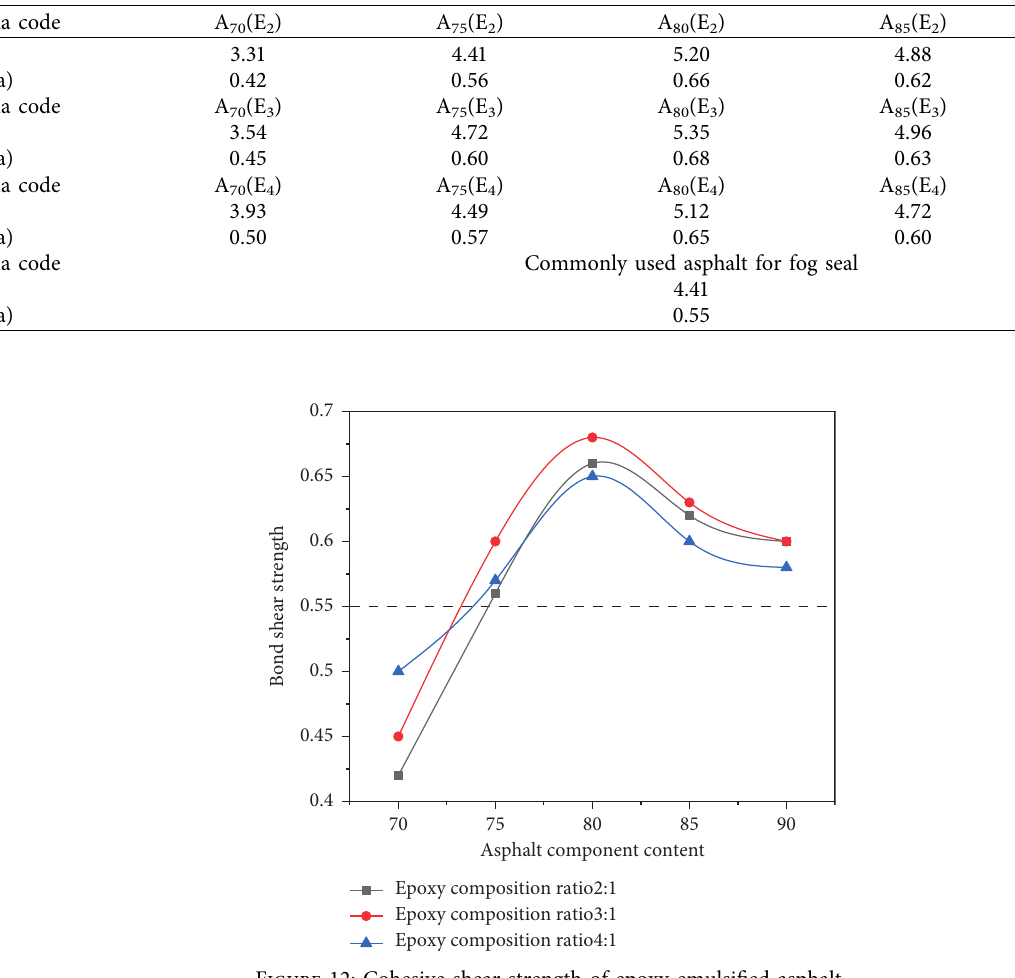
Table 7: Bond shear strength.